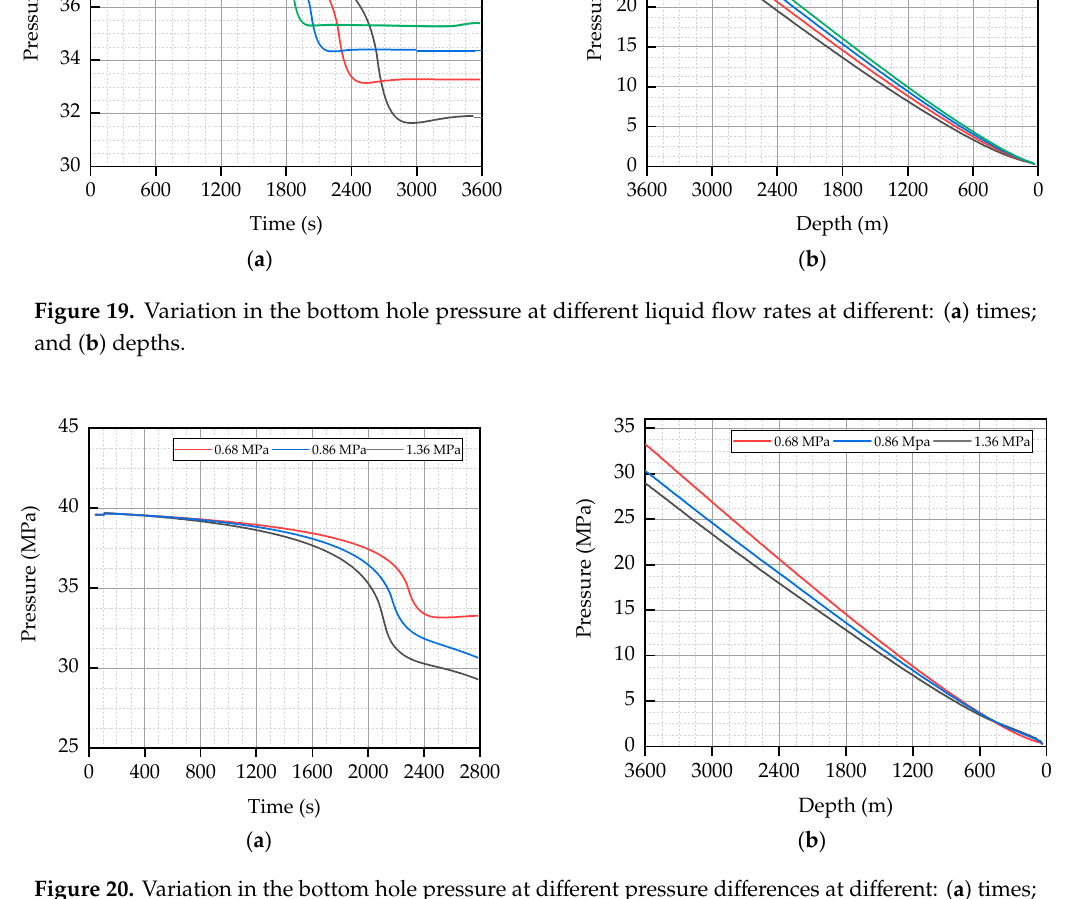
Figure 20. Variation in the bottom hole pressure at different pressure differences at different: ( a ) times; and ( b ) depths.